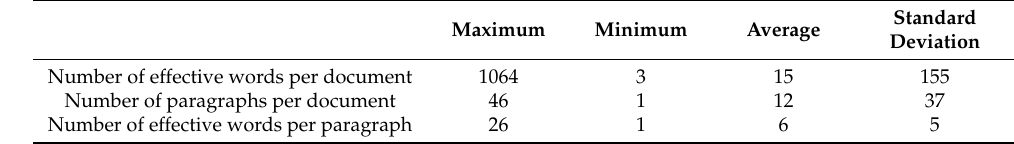
Table 3. Statistical Analysis of Text Data.